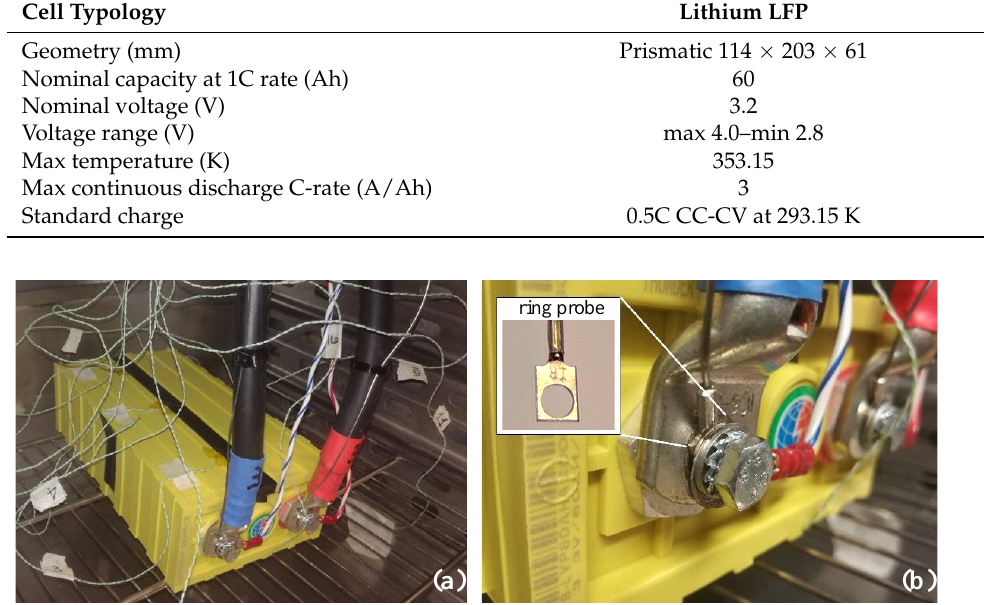
Figure 1. Cell inside the climatic chamber. ( a ) Any labelled thermocouple refers either to cell surface, electrode, or air temperature. ( b ) Detail of the ring probe placed at the cell positive electrode.